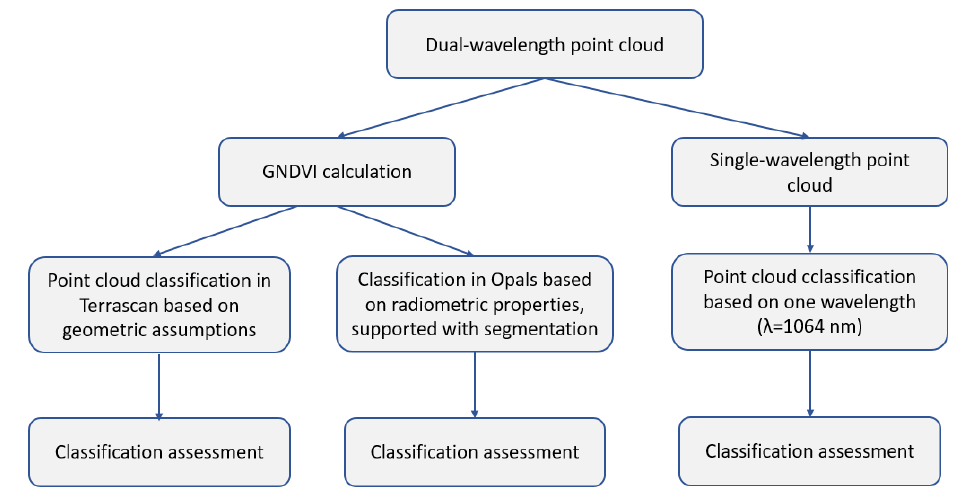
Fig. 2 Diagram shwing the classification approach proposed in the